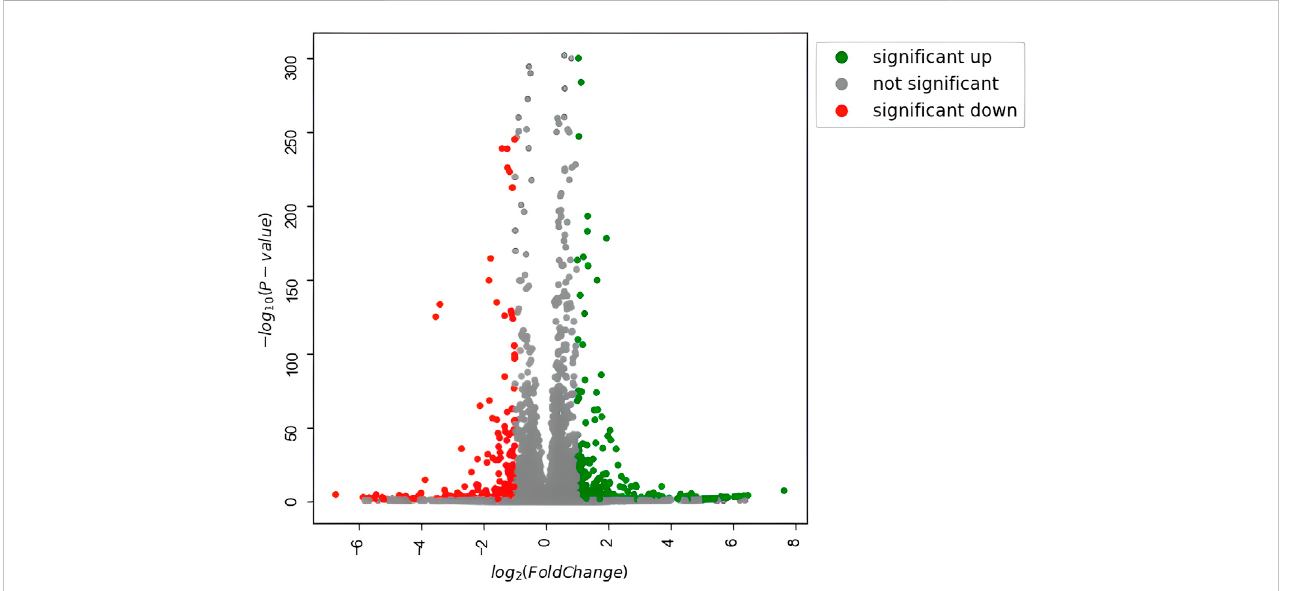
FIGURE 3 Volcano plot of differentially expressed genes. Signi fi cantly upregulated genes [adjusted p value ≤ .05 and log2(FC) > 1] are in green; signi fi cantly downregulated genes [adjusted p value ≤ .05 and log2(FC) < 1] are in